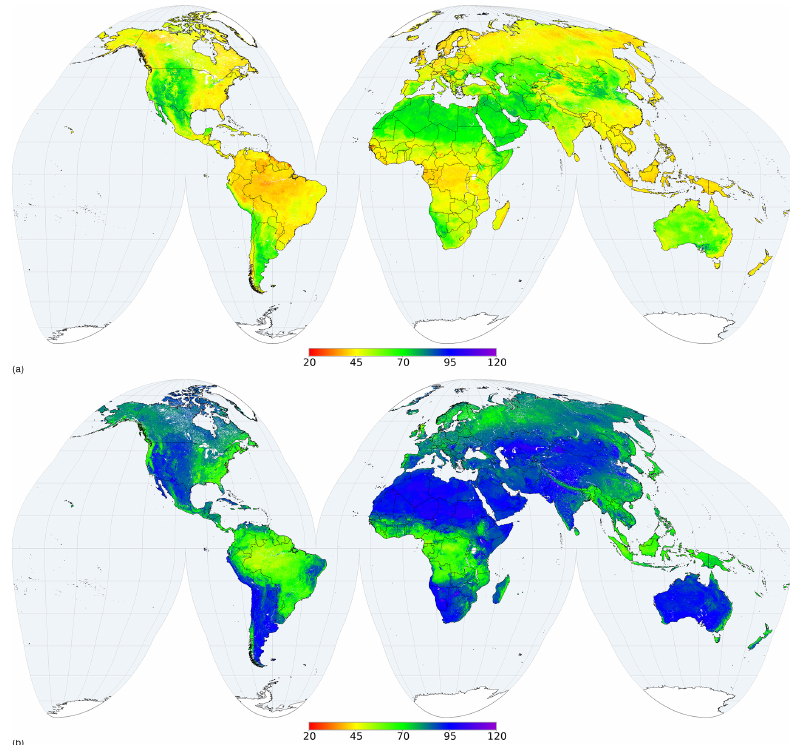
Figure 9. Prediction distribution for pH water (10pH) in the 60 to 100cm depth interval, (a) for mean and (b) for median.